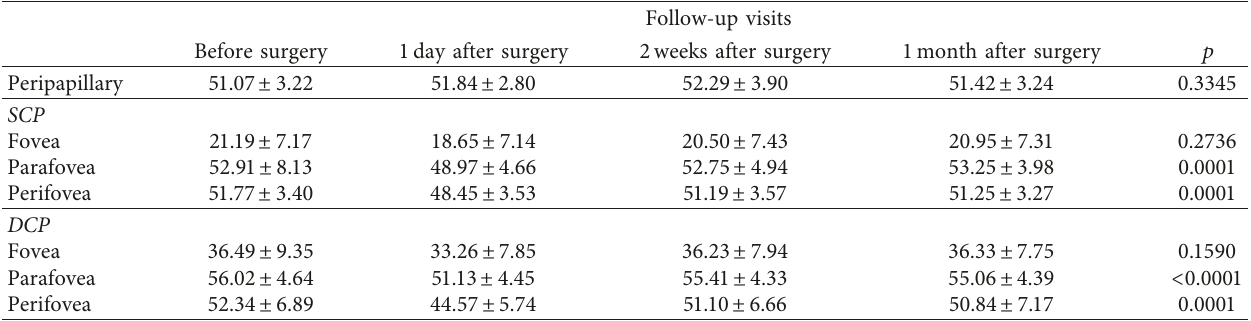
Table 2: Vessel density (%) before and after SMILE with OCTA.